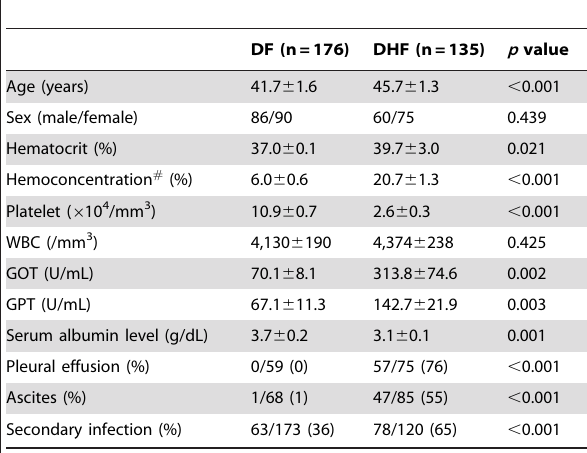
Table 1. Demographic data of dengue patients with DF and DHF.